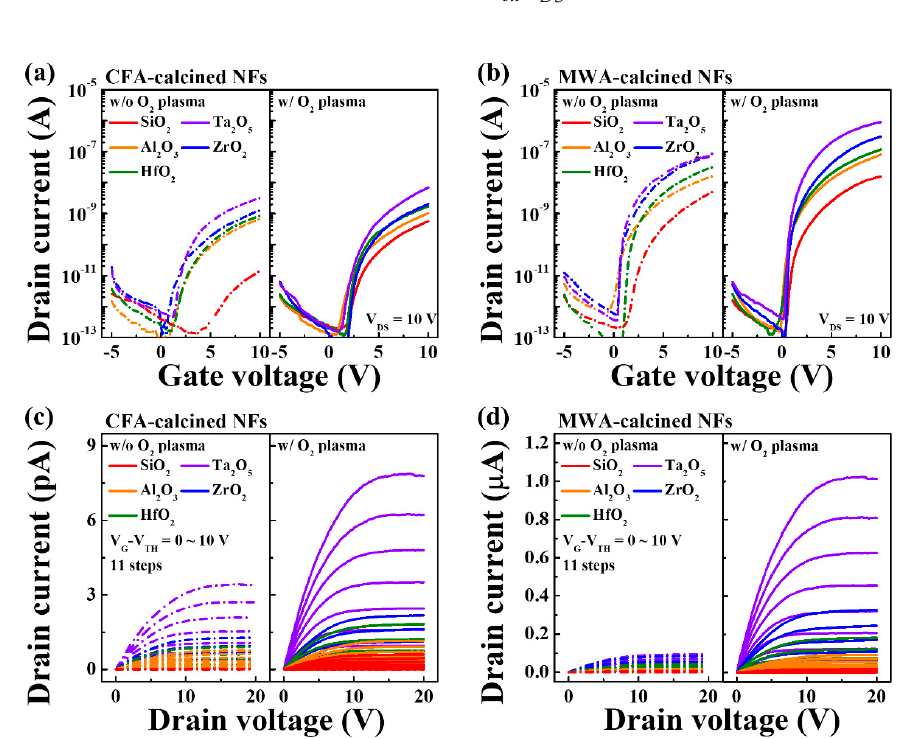
Figure 5. Electrical properties of bottom-gate-type IGZO NF FETs with different high- k dielectrics. ( a , b ) are curves of transfer characteristics (I D –V G ) and ( c , d ) are curves of output characteristics (I D –V D ). Dashed and solid lines indicate properties of FETs before and after postcalcination oxygen plasma treatment, respectively.